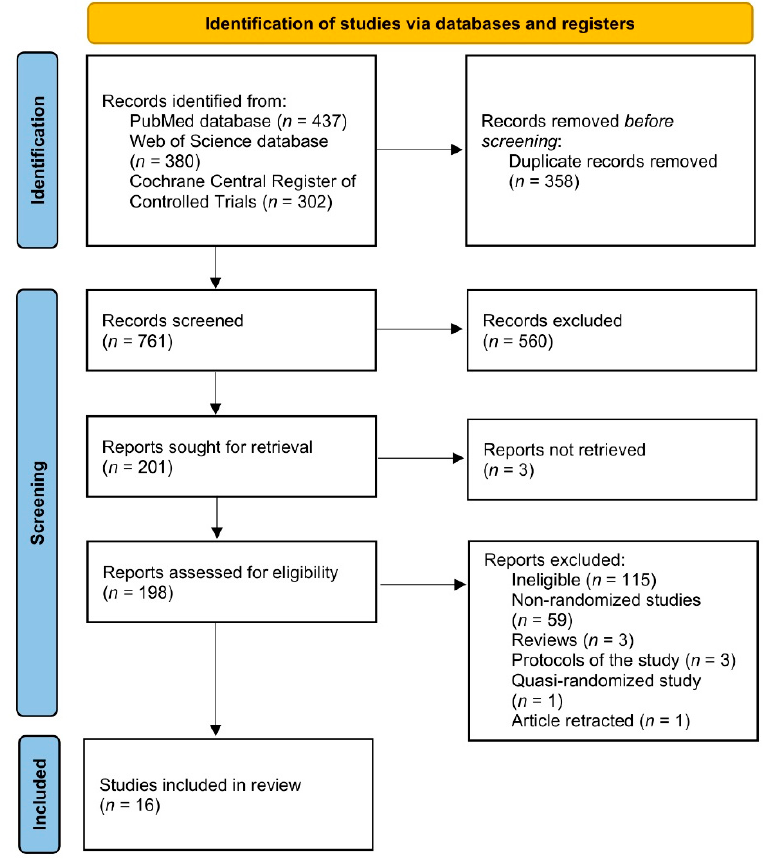
Figure 1. The procedure of identification, screening, and inclusion applied within the systematic review.